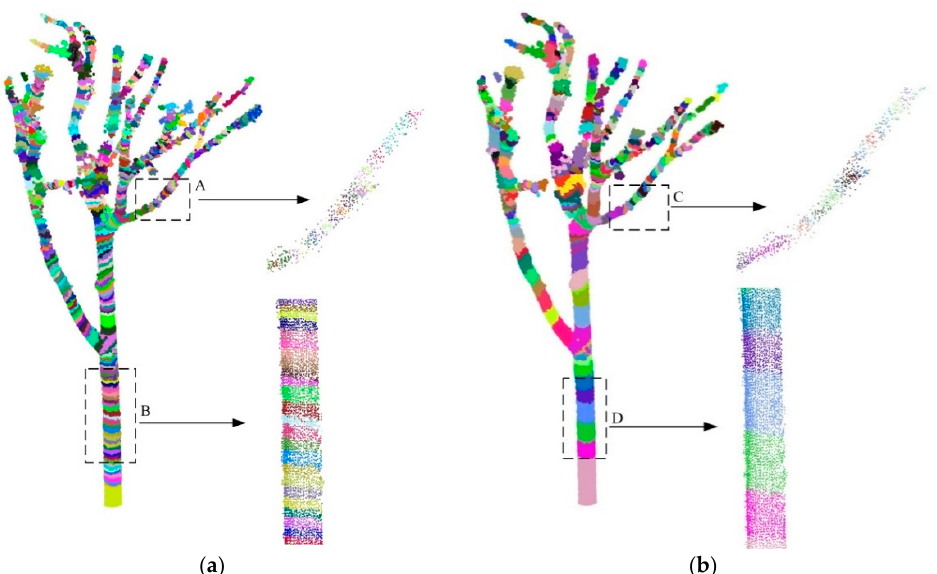
Figure 5. Local object primitive self-adaptive constraint adjustment. ( a ) Segmented object primitives based on the joint neighboring growing; ( b ) result of object primitive self-adaptive adjustment. Different primitives in ( a , b ) are rendered in different colors.